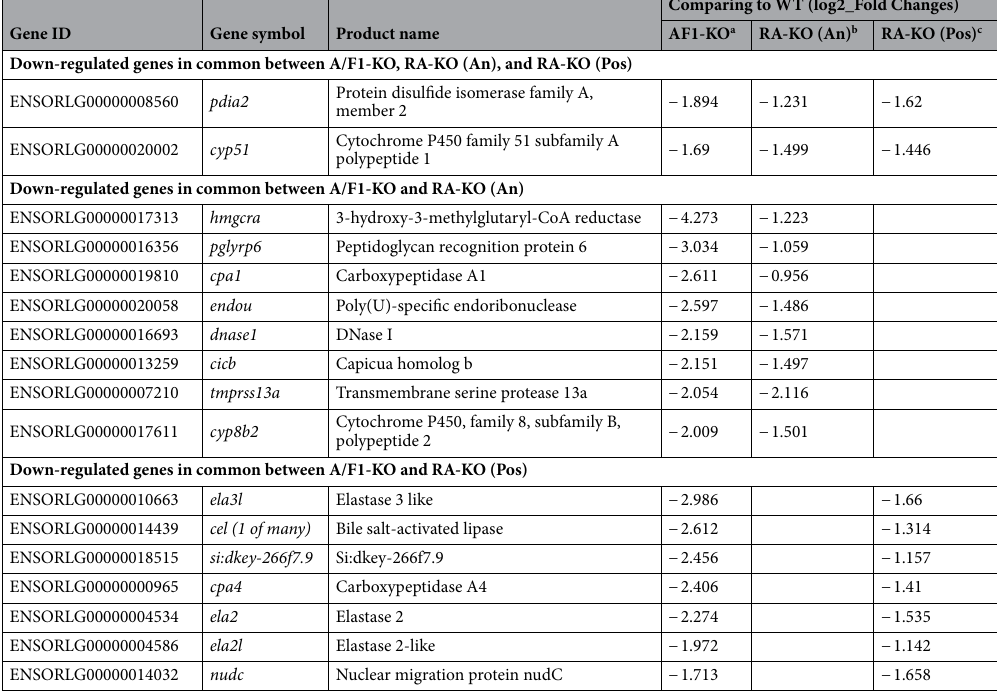
Table 2. Comparison of down-regulated differentially expressed genes (DEGs) in IL-17A/F1-KO and IL-17RA1-KO medaka intestines. a Significantly down-regulated DEGs in IL-17A/F1-KO medaka (whole intestine). b Significantly down-regulated DEGs in IL-17RA1-KO medaka (anterior intestine). c Significantly down-regulated DEGs in IL-17RA1-KO medaka (posterior